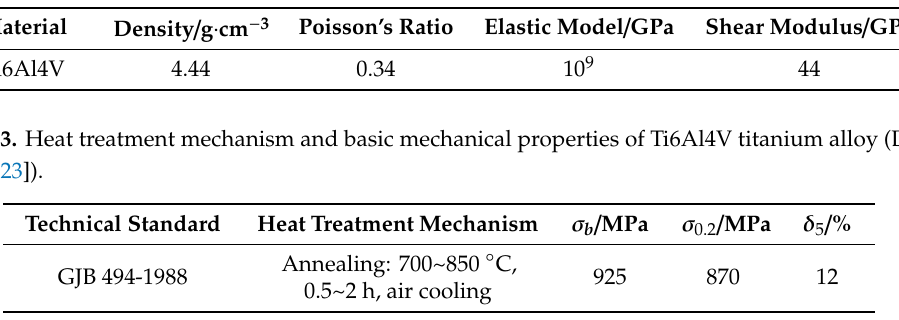
Table 2. Physical parameters of Ti6Al4V titanium alloy (Data from [23]).